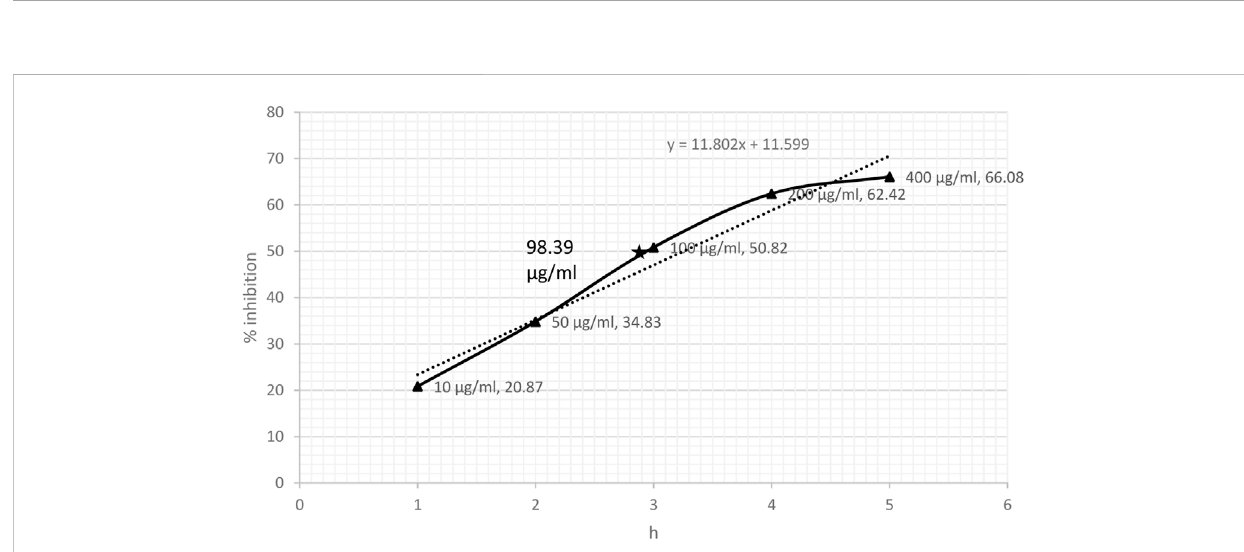
FIGURE 3 Nitric oxide radical scavenging assay against various concentrations of C. borivilianum root extract (CRE). IC 50 was estimated based on the graph of respective doses.